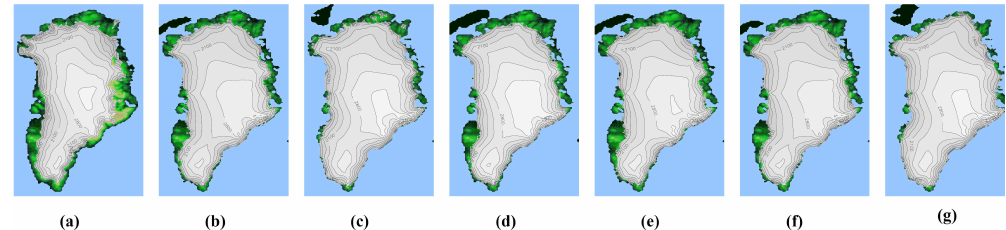
Figure 11. Ice-sheet configurations for a) observed present day GrIS (from Bamber et 2 Fig. 11. Ice-sheet configurations for (a) observed present day GrIS (from Bamber et al., 2001) and (b) to (g) configurations for the six selected experiments shown in Table 5 and Fig. 10 (experiment numbers 10, 67, 99, 165, 233 and 240 al., 2001) and b) to g) configurations for the six selected experiments shown in Table 3